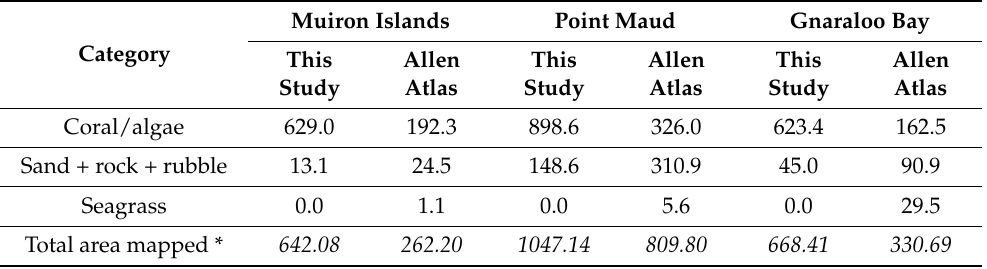
Muiron Islands Point Maud This Allen This Allen This Study Atlas Study Atlas Study